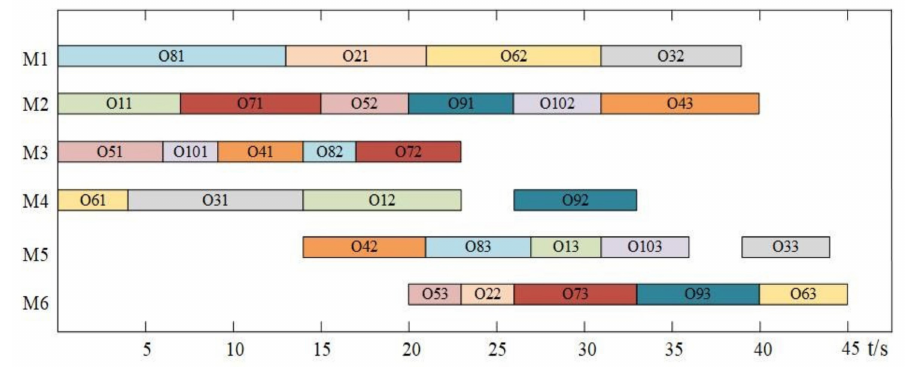
Figure 10. The Gantt chart of the scheduling results.